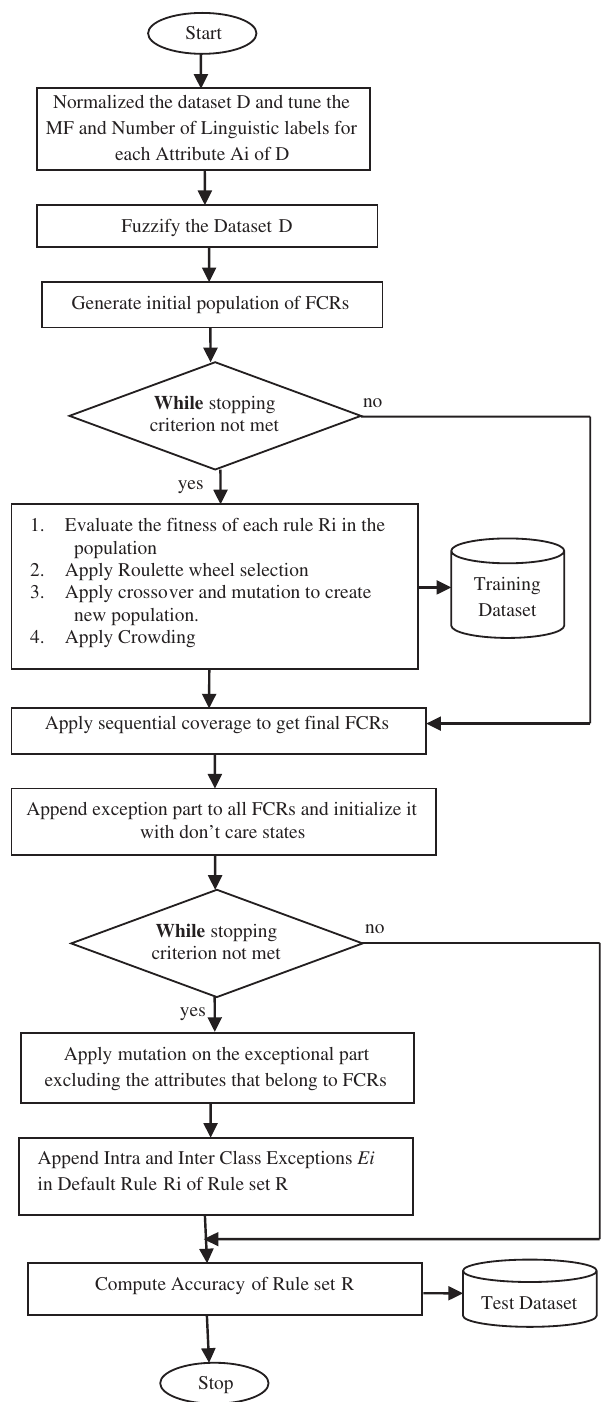
Figure 8: The Flowchart of the Overall System.